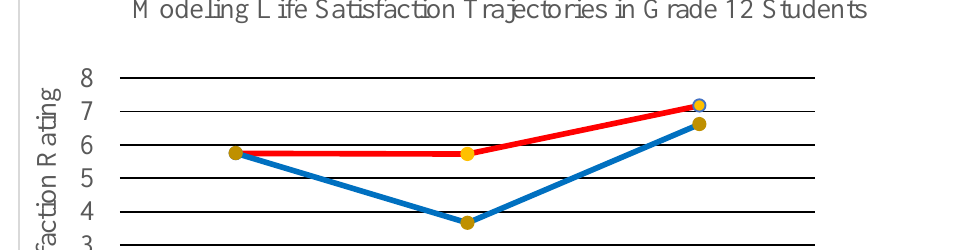
Figure 3. Class 2 relationship with stress, negative and positive affect. 4. Discussion The current study sought to assess the trajectories of life satisfaction (past, current, and future assessed cross-sectionally) among Canadian Grade 12 students (i.e., those fin- ishing high school) during the first wave of the COVID-19 pandemic. We focused on this group due to the many losses they experienced during the pandemic, which interfered with their final months of high school and led to cancelled proms, graduation ceremonies, and an uncertain transition into postsecondary education. Using LCA, we found that two subgroups emerged from the sample. The subgroups were similar regarding their ratings of life satisfaction pre-pandemic. In addition, both groups showed the typical pattern of anticipating that things would improve in the future (i.e., the next five years), reflecting a degree of resilience and openness to increasing opportunities despite the many losses they experienced. What differed between the groups were their experiences during COVID-19 and the degree to which they anticipated improvements in life satisfaction post COVID- 19. The optimists experienced only a small decline in life satisfaction during the pandemic, appearing more resilient to the impacts of COVID-19, and felt as though they would bounce back to optimal life satisfaction in the future. The second subgroup, the realists,